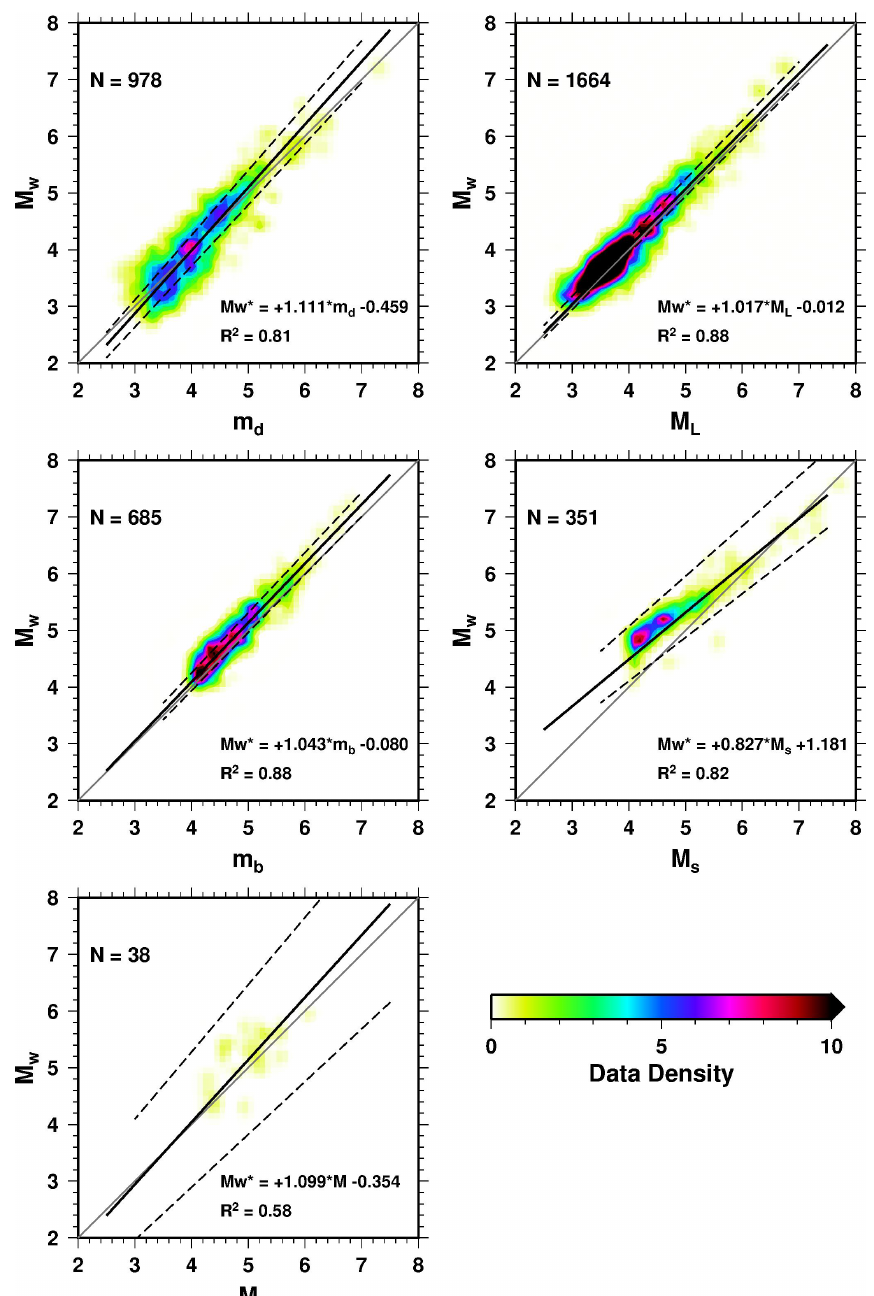
Figure 5. Magnitude relations between M w and the other scales. The data density in 0.1 magnitude intervals is shown with coloured counters. N is the total number of magnitude pairs. The solid line is the best linear fit of the orthogonal regression, whereas the dashed lines show the 95% confidence interval after bootstrapping. Grey line indicates the y = x